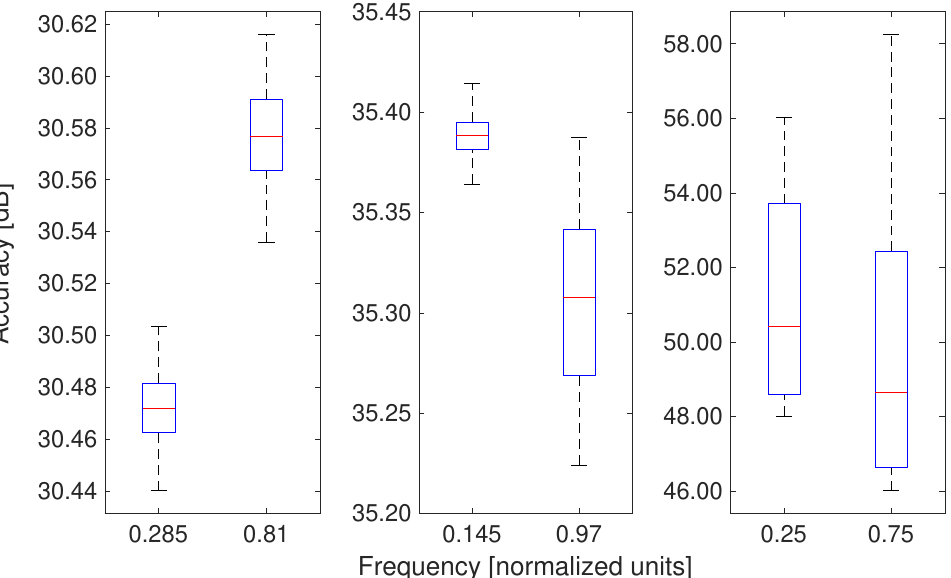
Figure 6. Boxplots for the KPI utilized to evaluate the accuracy of the proposed data fusion method. The values are related to a selection of the test frequencies to highlight how the dispersion of the KPI changes at different performance